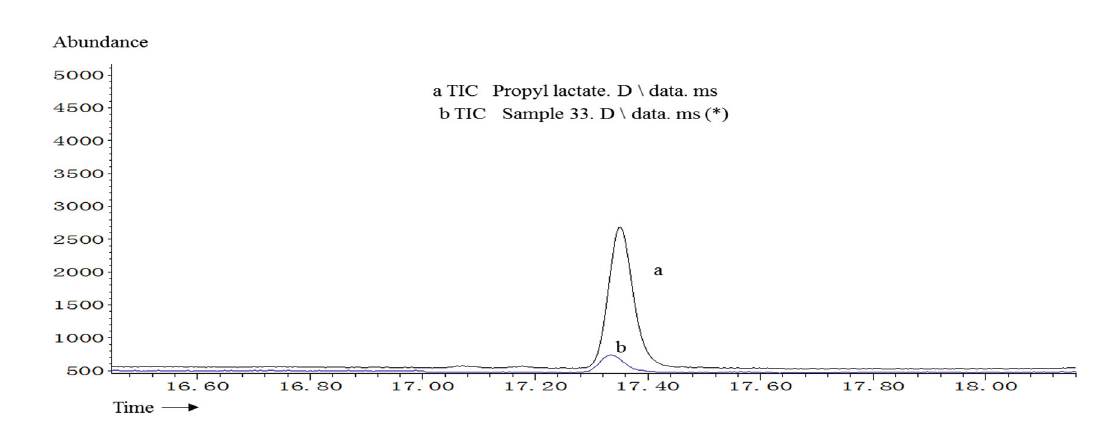
Figure 2. The magnifying TIC of sample 33 and propyl lactate at 17.4 min. The two magnified TICs are shown, one is the unknown compound in sample 33 (a TIC), and the other is propyl lactate standard (b TIC) at 17.4